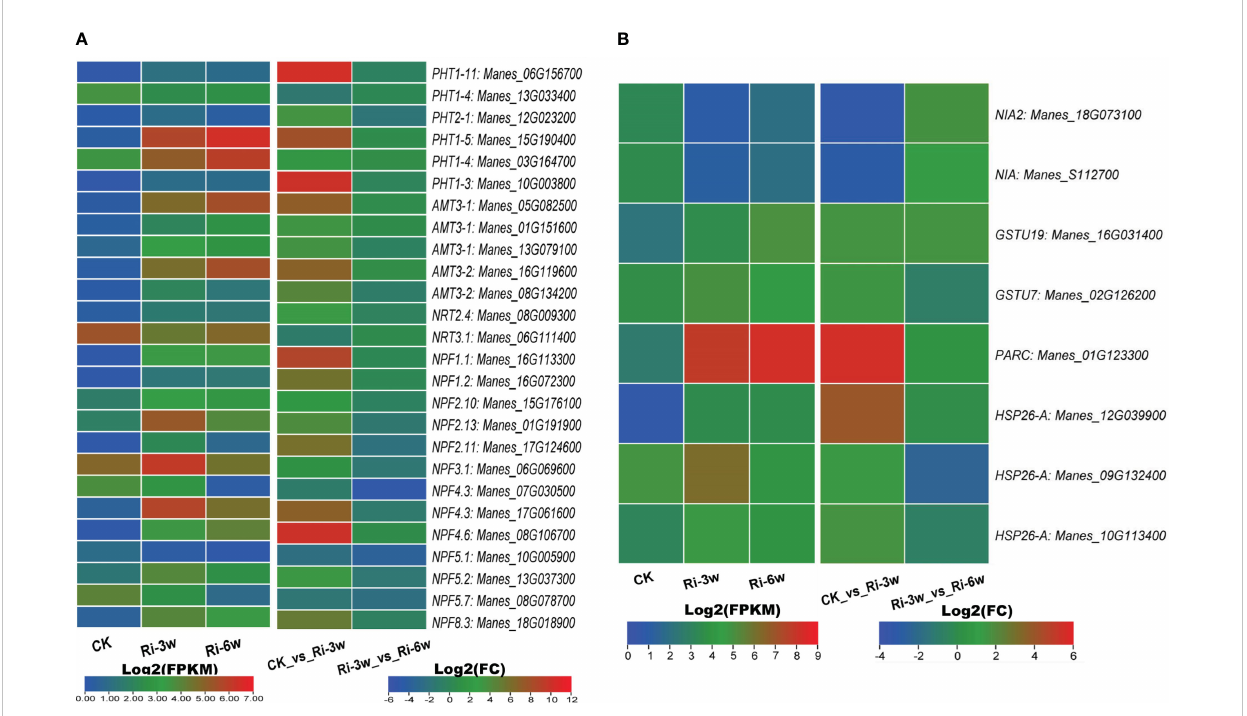
FIGURE 5 Transcription levels of DEGs related to nitrogen and phosphorus metabolisms. (A) Phosphorus and nitrogen transporters. (B) Other DEGs related to nitrogen metabolism. FPKM, Fragments Per Kilobase of transcript per Million mapped reads. PHT, inorganic phosphate transporter; AMT, ammonium transporter; NRT, high-af fi nity nitrate transporter; NPF, protein NRT1/PTR family-like. Genes ’ annotation is presented in Tables S9A,